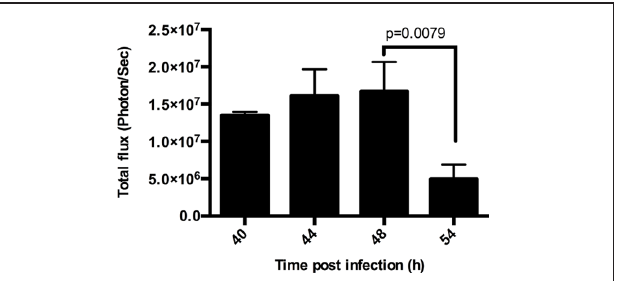
FIGURE 1 | Duration of Plasmodium yoelii -Luc ( Py -Luc) liver stage (LS) growth. Graph representing quantification of total flux from infected and untreated mice imaged at 40, 44, 48, and 54 h after sporozoites (SPZ) injection. n = 3 for 40 h, 4 for 44 h, and 5 each for 48, and 54 h. Graph represents Mean ± SD. Mann–Whitney test was performed and p < 0.05 considered as